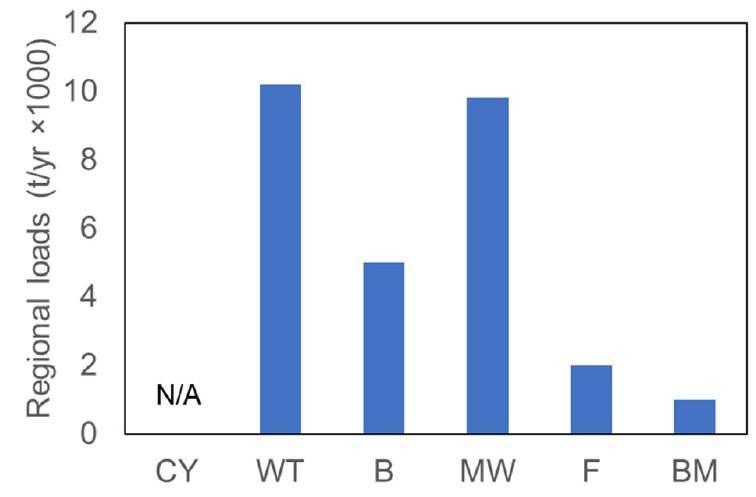
Figure 2. PS-II Herbicide regional load estimate in 2009 (CY = Cape York, WT = Wet Tropics, B = Burdekin, MW = Mackay Whitsunday, F = Fitzroy and BM = Burnett Mary) [23] .